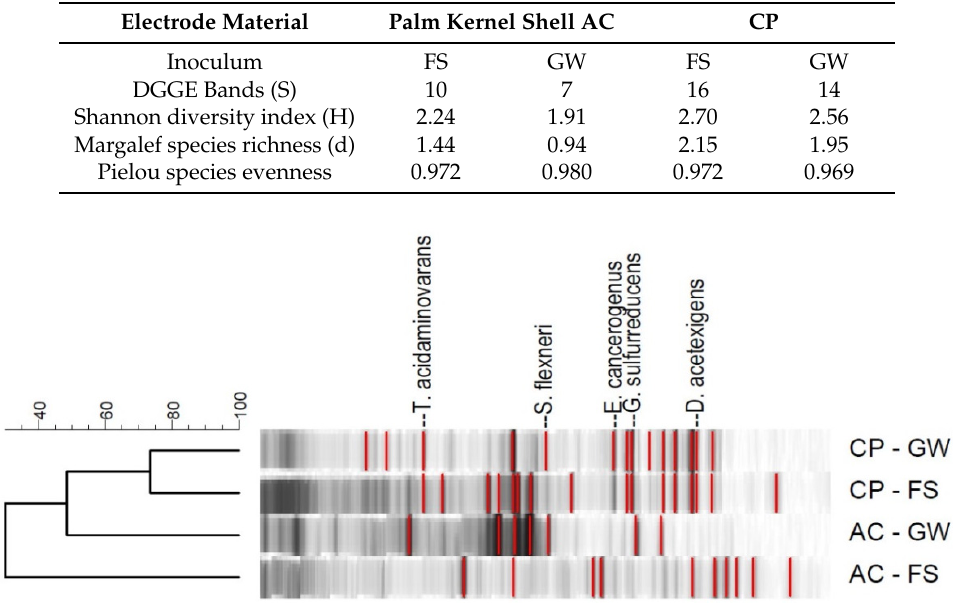
Table 3. DGGE results including number of bands, Shannon diversity index, Margalef species richness and Pielou species evenness [15,28].